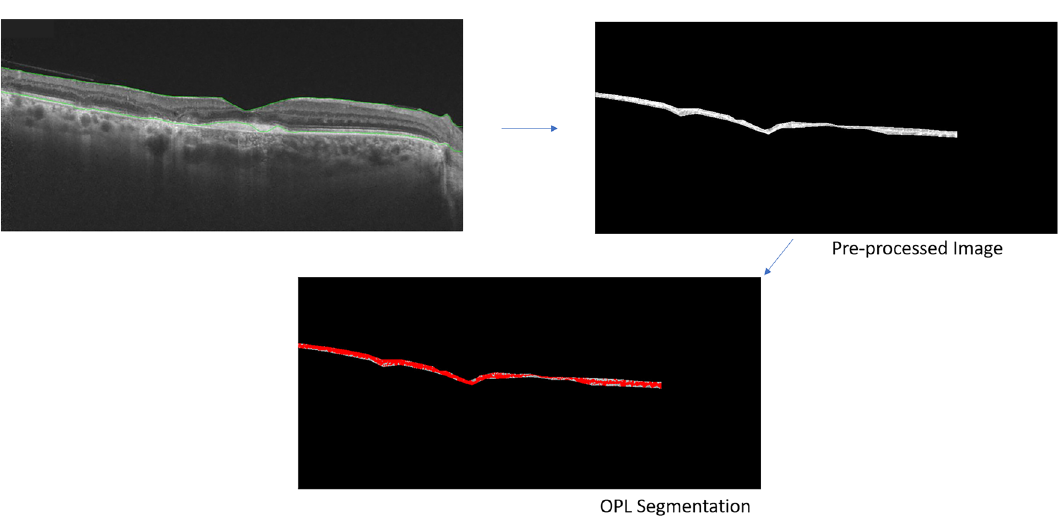
Figure 2. Illustrates the segmentation and cropping of the outer plexiform layer from the optical coherence tomography line scan, and subsequent thresholding for calculation of the area using an automated algorithm on